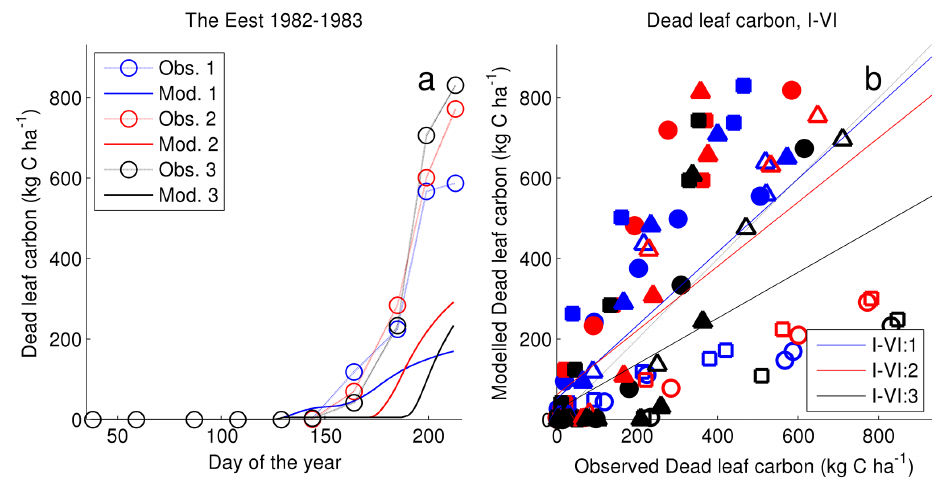
Figure A3. (a) Dead leaf comparison between modelled (thick lines) and observations for the Eest, the Netherlands 1982–1983. Blue lines are with 0 input of N fertiliser; red lines are with an input of 60kgNha − 1 ; and black lines are with 160kgNha − 1 . (b) A comparison between modelled and observed C mass of dead leaves for winter wheat for the Eest ( ◦ ), the Bouwing ( (cid:3) ) and PAGV ( (cid:52) ), the Netherlands for the seasons 1982–1983 and 1983–1984. Blue symbols are with a low input of N fertiliser; red are with a medium input of N; and black are with a high input. Open symbols are for the season 1982–1983, and closed symbols are for the season